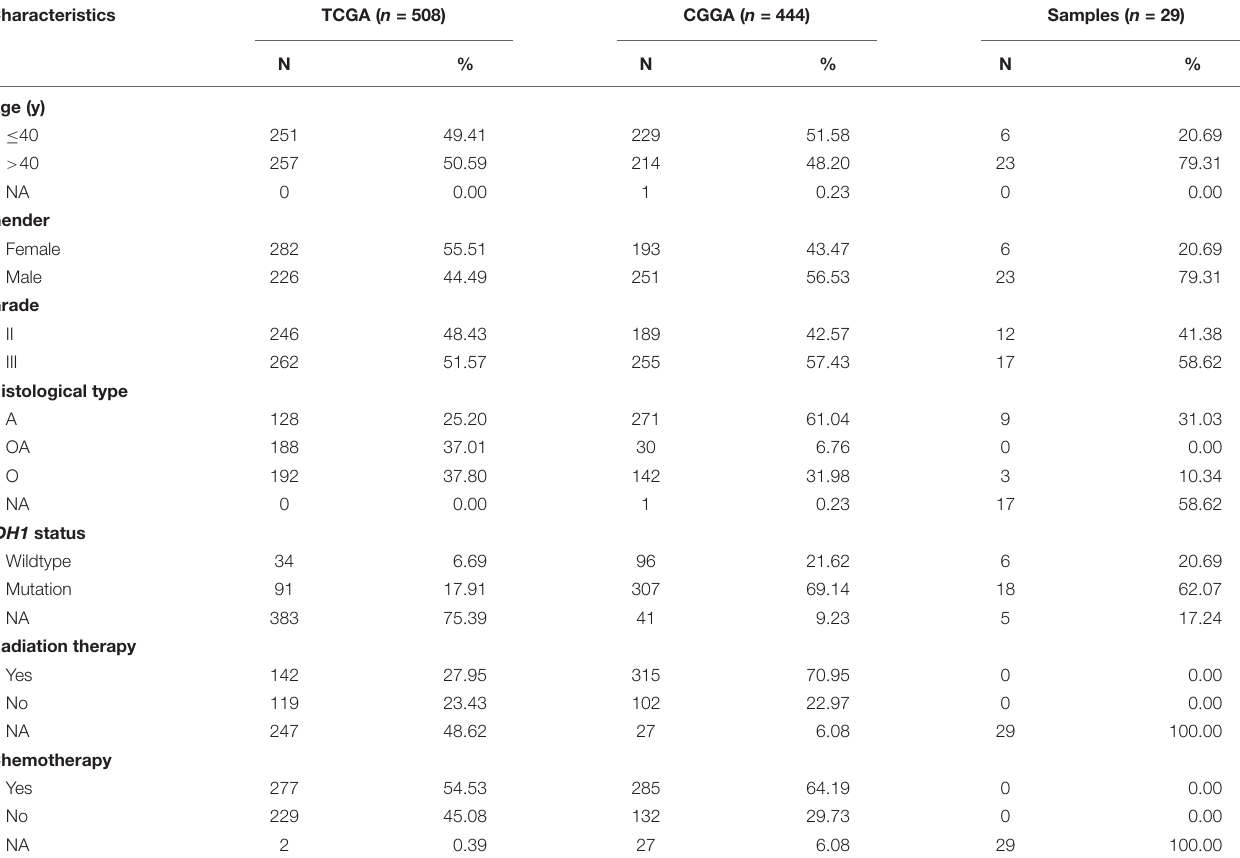
TABLE 1 | The characteristics of include